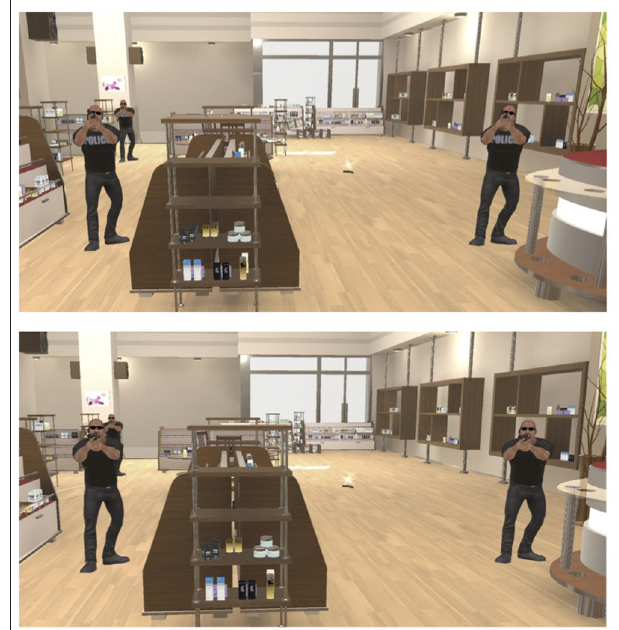
participants saw of their enemies, that is, assigned gang members (whose enemies are police officers, Top image) and assigned police officers (whose enemies are gang members, Bottom